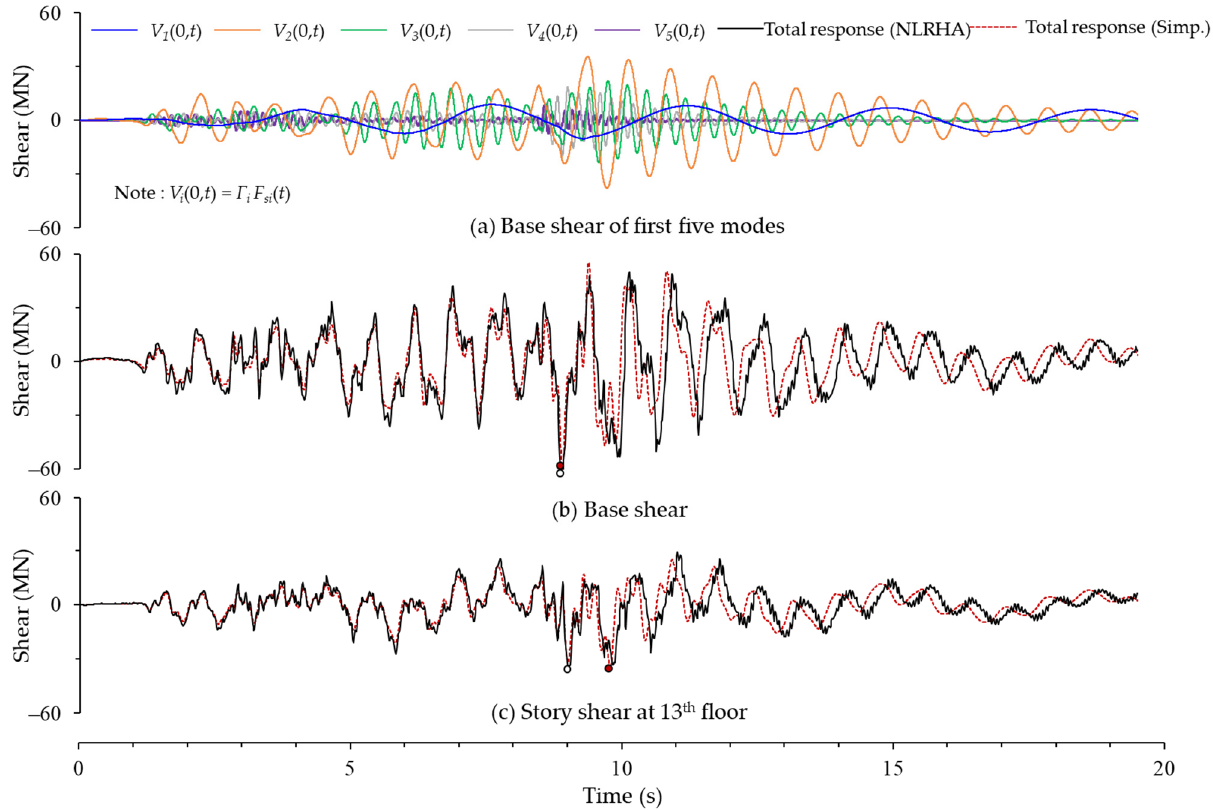
Figure 16. Modal base and story shear time history of building B3 in the x axis caused by EQ1.